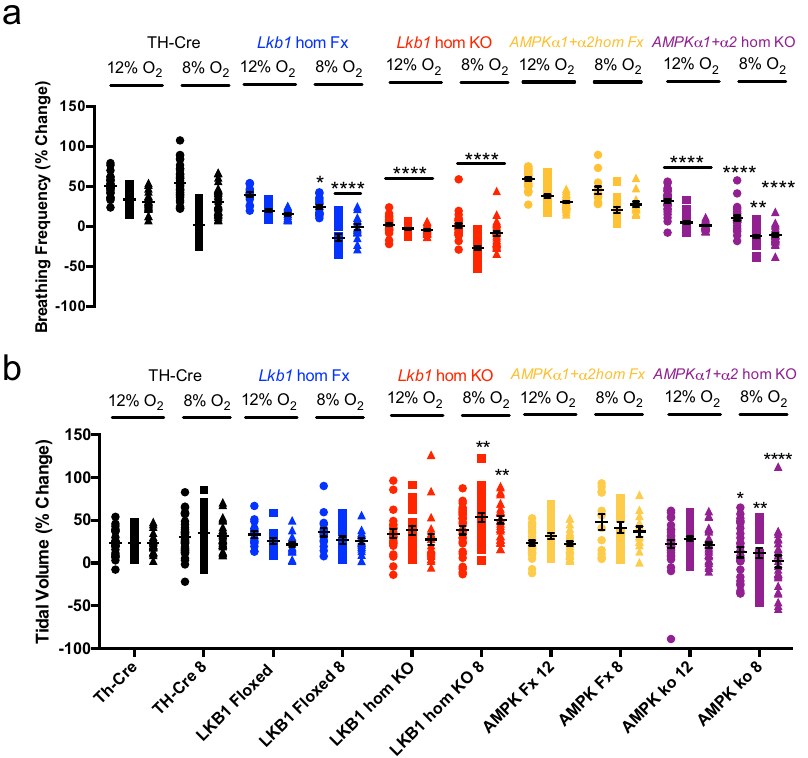
Fig. 6 Conditional deletion of Lkb1 and AMPK in tyrosine hydroxylase expressing cells attenuates increases in breathing frequency during hypoxia but only Lkb1 deletion augments increases in tidal volume during severe hypoxia. Dot plots of mean ± SEM for changes in a breathing frequency and b tidal volume at the peak of the Augmenting Phase (~30 s), at ~100 s following Roll Off and during the plateau of the Sustained Phase (~300 s) of the ventilatory response to mild (12% O 2 ) and severe (8% O 2 ) hypoxia for TH-Cre (black; 12% O 2 , n = 25 independent experiments; 8% O 2 , n = 37 independent experiments), Lkb1 homozygous fl oxed ( Lkb1 hom Fx, blue; 12% O 2 , n = 14 independent experiments; 8% O 2 , n = 15 independent experiments) that are ~90% hypomorphic for LKB1 and conditional Lkb1 homozygous knockout mice ( Lkb1 hom KO, red; 12% O 2 , n = 22 independent experiments; 8% O 2 , n = 30 independent experiments). These data are also compared with outcomes for AMPK α 1 + α 2 homozygous fl oxed mice ( AMPK α 1 + α 2 hom Fx, beige, 12% O 2 , n = 30 independent experiments; 8% O 2 , n = 13 independent experiments) and conditional AMPK α 1 + α 2 homozygous knockout mice ( AMPK α 1 + α 2 hom KO, purple, 12% O 2 , n = 30 independent experiments; 8% O 2 , n = 26 independent experiments). * = p < 0.05, ** = p < 0.01, **** = p < 0.0001 compared to